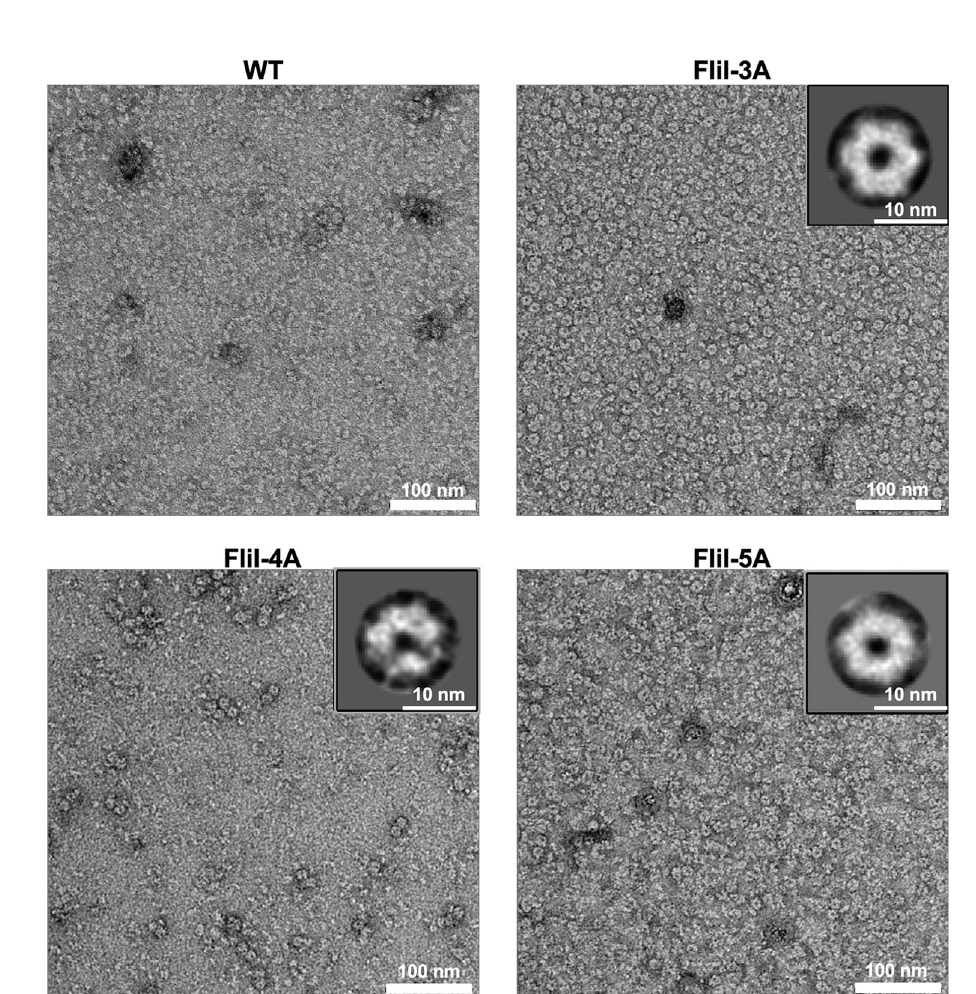
Fig. 5 Electron micrographs showing the oligomerization ability of FliI, FliI-3A, FliI-4A, and FliI-5A. Each puri fi ed FliI sample (1 μ M) was preincubated with 5 mM MgCl 2 , 5 mM ADP, 5 mM AlCl 3 , and 15 mM NaF for 20 min at room temperature, and then the mixture was stained with 1% uranyl acetate and visualized by electron microscopy. Electron micrographs were recorded at a magni fi cation of ×50,000. Insets indicate reference-free 2D class average images calculated by Effect of the fl iI-5A mutation on the ATPase activity of FliI . might suppress FliI oligomerization at the FlhA C -FlhB C docking FliI 6 ring formation is required for ef fi cient fl agellar protein platform. To clarify this possibility, we measured the ATPase export by the PMF-driven export gate complex even in the Table 1). The ATPase activity of FliI-5A was higher than the absence of FliH 19 , raising the possibility that the fl iI-5A mutation